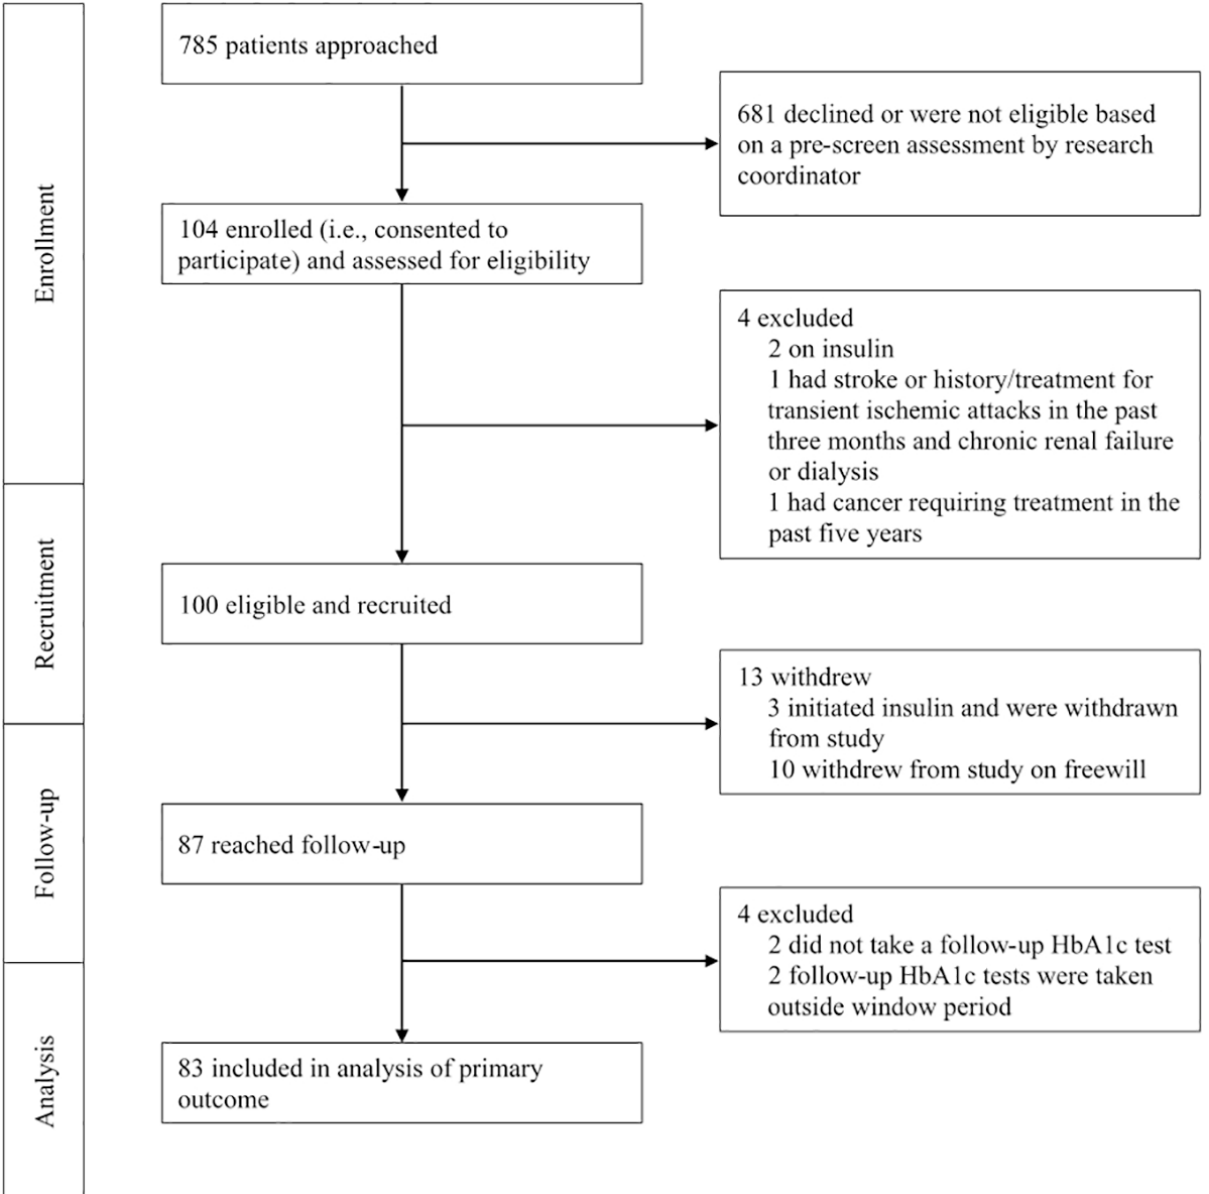
Figure 1. Participant recruitment and retention Consolidated Standards of Reporting Trials flow